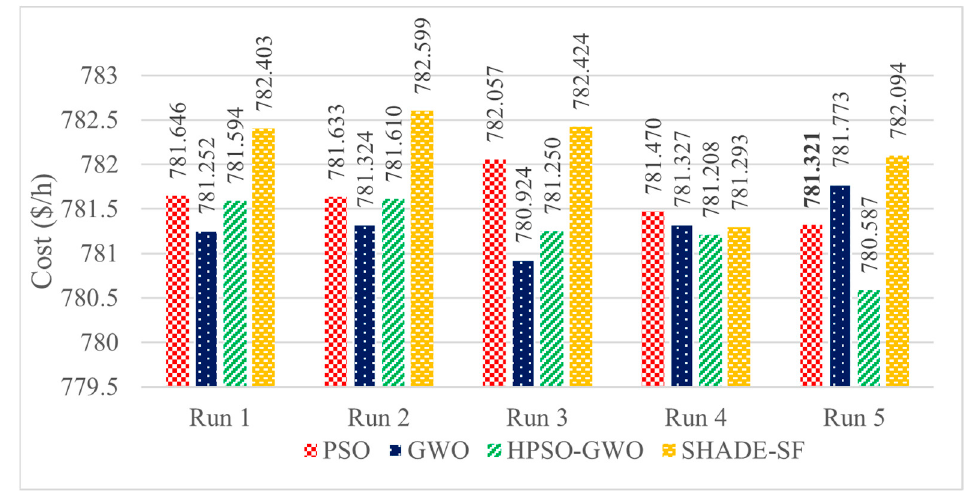
Figure 24. Cost comparison of 5 runs (Case 4). Table 6. Simulation results for Case 4.